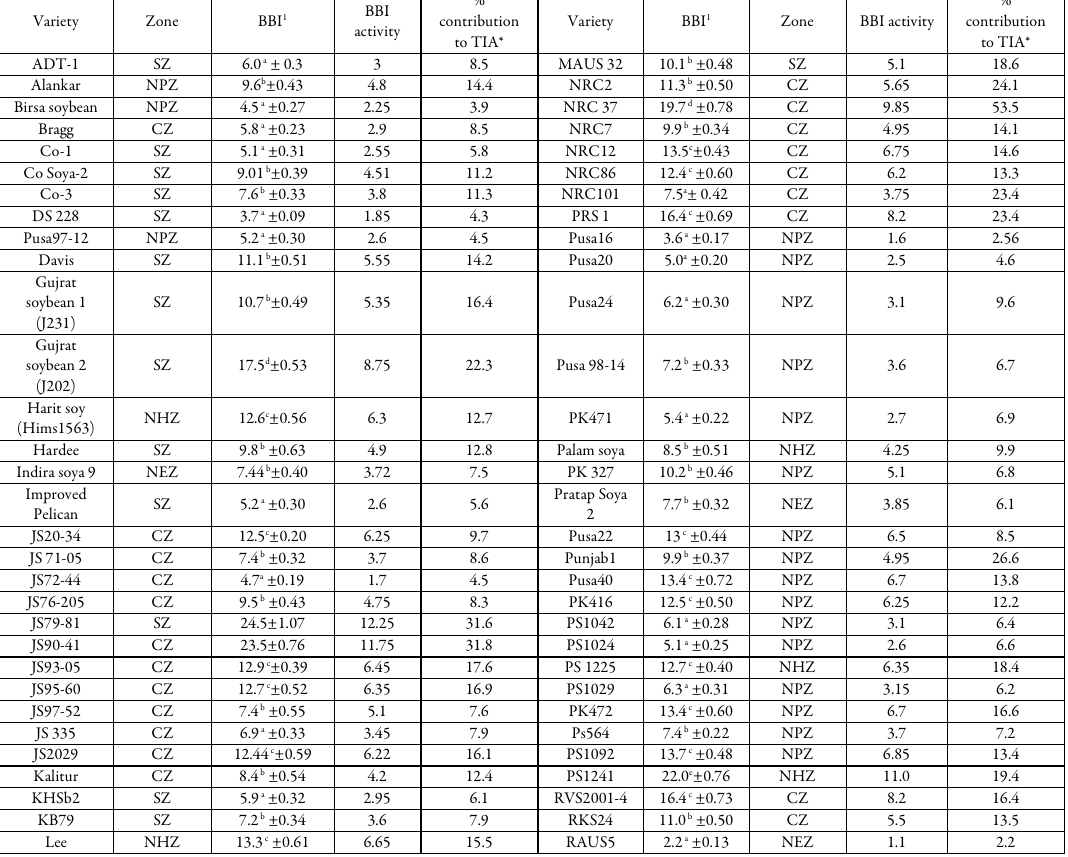
Table 1. Genotypic variation of BBI conc. (mg/g defatted soy flour) in soybean varieties and its contribution to